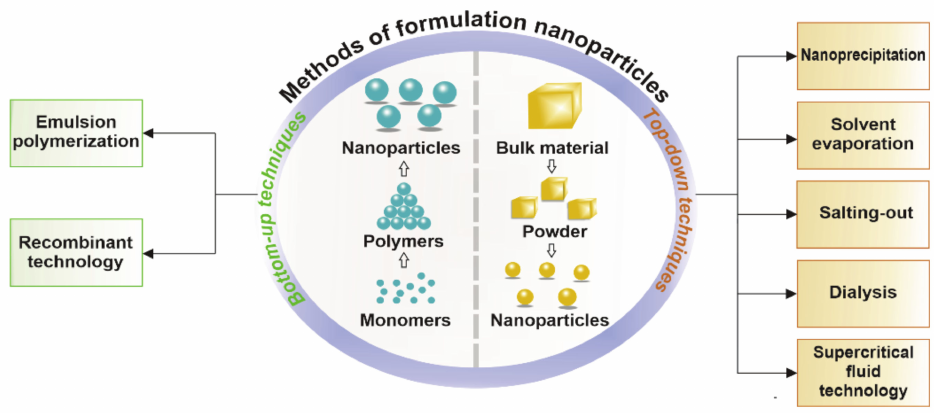
Figure 2. Methods of formulation